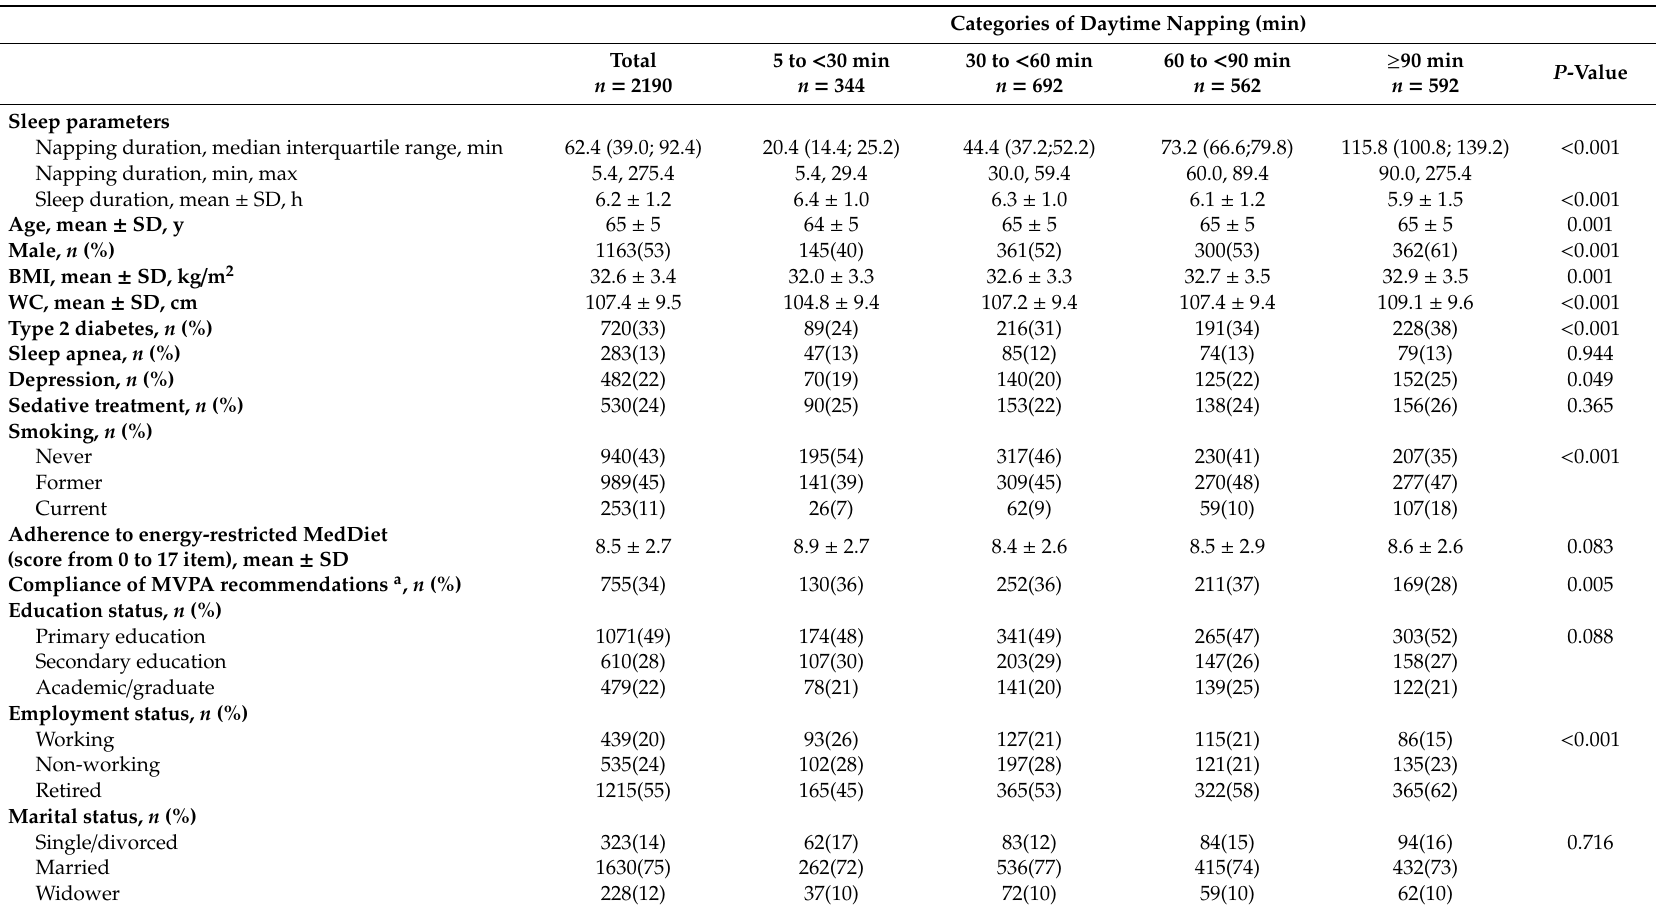
Table 1. Baseline characteristics of the study population from PREDIMED-Plus trial across categories of daytime